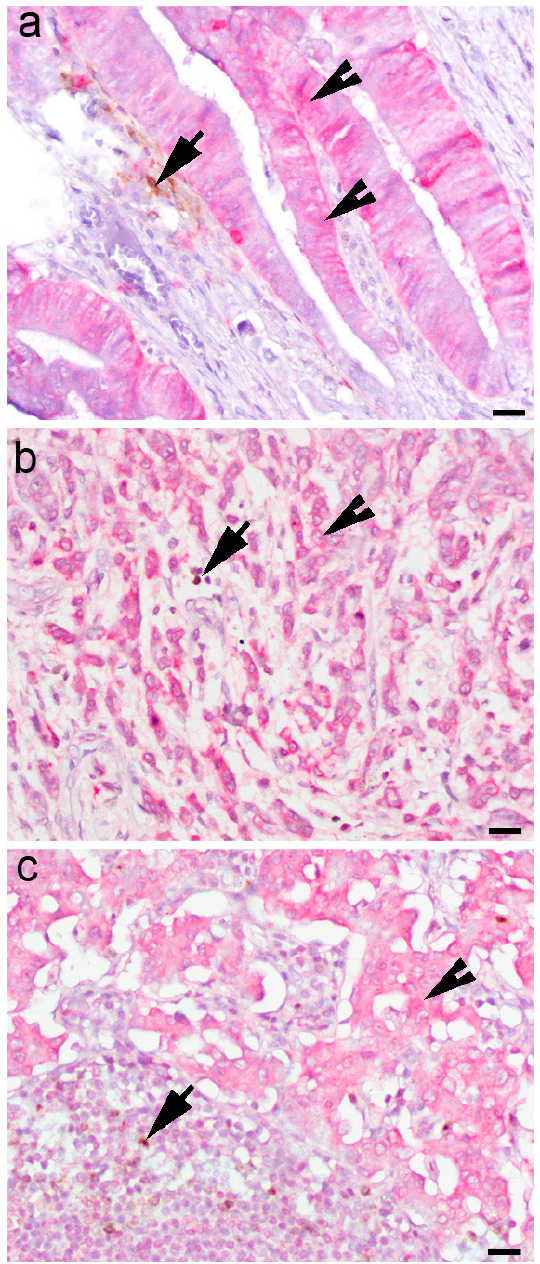
Figure 2. IFN- γ expression in the cytoplasm of ( a ) dysplastic epithelial cells in gastric mucosa and ( b ) a diffuse type of gastric cancer and tumor cells in metastatic lymph node. ( c ) IFN- γ -positive cells (arrowheads), CTLA4 + cells (arrows), indirect double immunohistochemistry, chromogen DAB for CTLA4 and fast red for IFN- γ . Scale bar ( a ) 50 µ M, ( b ) and ( c ) 80 µ